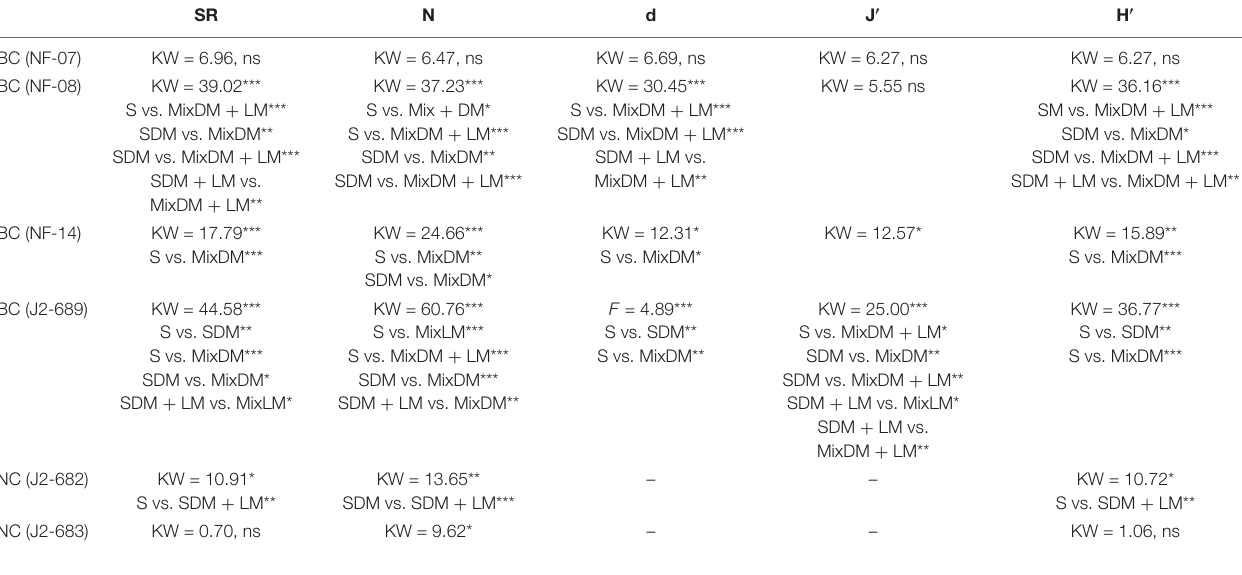
TABLE 3 | Analysis of variance for number of species (SR), number of individuals (N), Margalef index (d), Pielou’s evenness (J (cid:48) ), and Shannon index (H (cid:48) ) across the types of habitats for each of the six ROV dives at Baltimore Canyon (BC) and Norfolk Canyon (NC). SR N d J